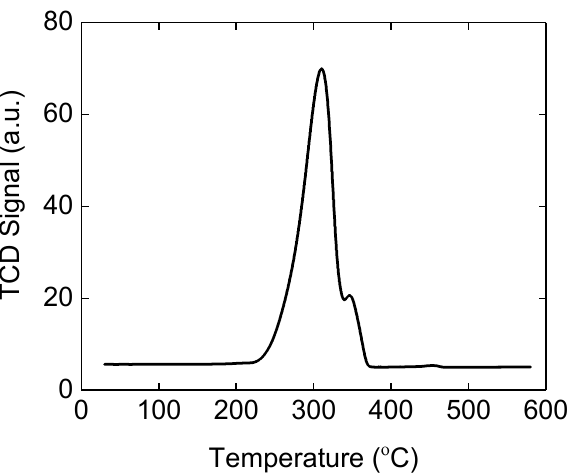
Figure 3. Temperature programmed reduction of powdered CuO fiber. A H 2 (4% in Ar) flow of 30 cm 3 · min − 1 , and a heating rate of 5 ◦ C min − 1 were applied. A maximum in reduction rate is observed at 300 ◦ C, followed by a small peak at 350 ◦ C. Figure A4 shows the X-Ray diffraction patterns of copper hollow fibers obtained after reduction for 1 h in 4 vol-% H 2 at 200, 250, 330, and 400 ◦ C, respectively. A temperature of 200 ◦ C in 4 vol-% H 2 is insufficient to reduce CuO to Cu, in agreement with the TPR profile, and diffraction lines of CuO are still dominant. Above 200 ◦ C, diffraction lines appear at 2 θ = 43.3, 50.4, and 74.1, indicative of metallic copper. The XRD patterns do not show any features of cuprous